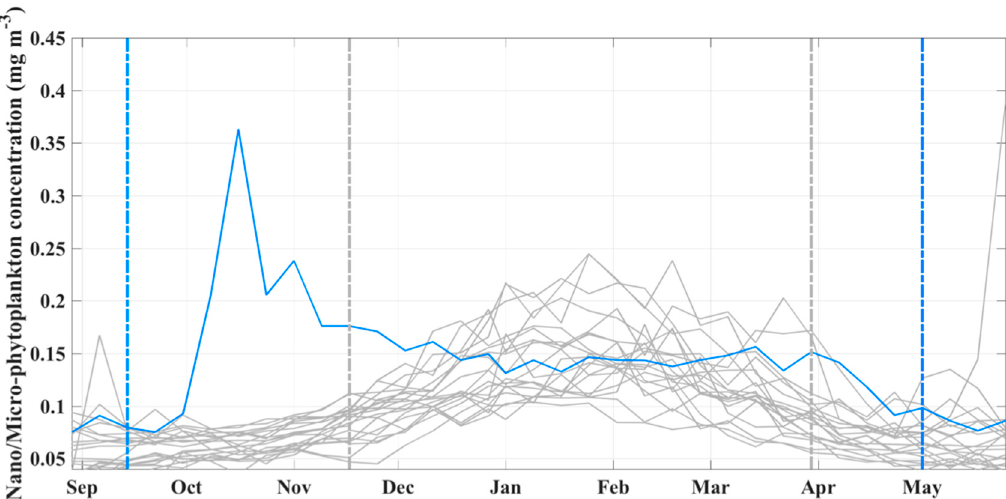
Figure 3. Time series of Chl-a concentration attributed to the combined nano/micro-phytoplankton assemblage ( C n,m ), alongside the timings of bloom initiation and termination (blue vertical dashed lines), for the blooming event detected during the autumn/winter of 2002/2003. The C n,m time series for the remaining years are shown in grey, alongside the climatological phenology metrics computed for the whole period (grey vertical dashed lines).